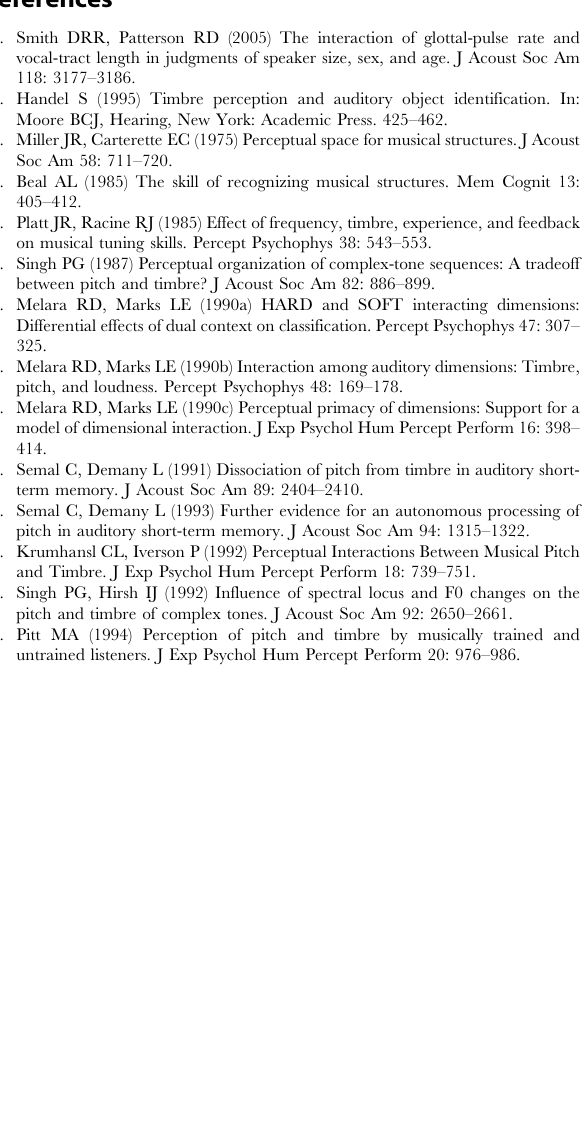
Figure S1 Results of the multidimensional scaling (MDS). (a) Stress as a function of the dimensionality of the MDS solution; (b) three-dimensional spatial representation based on the dissimilarity ratings for 10